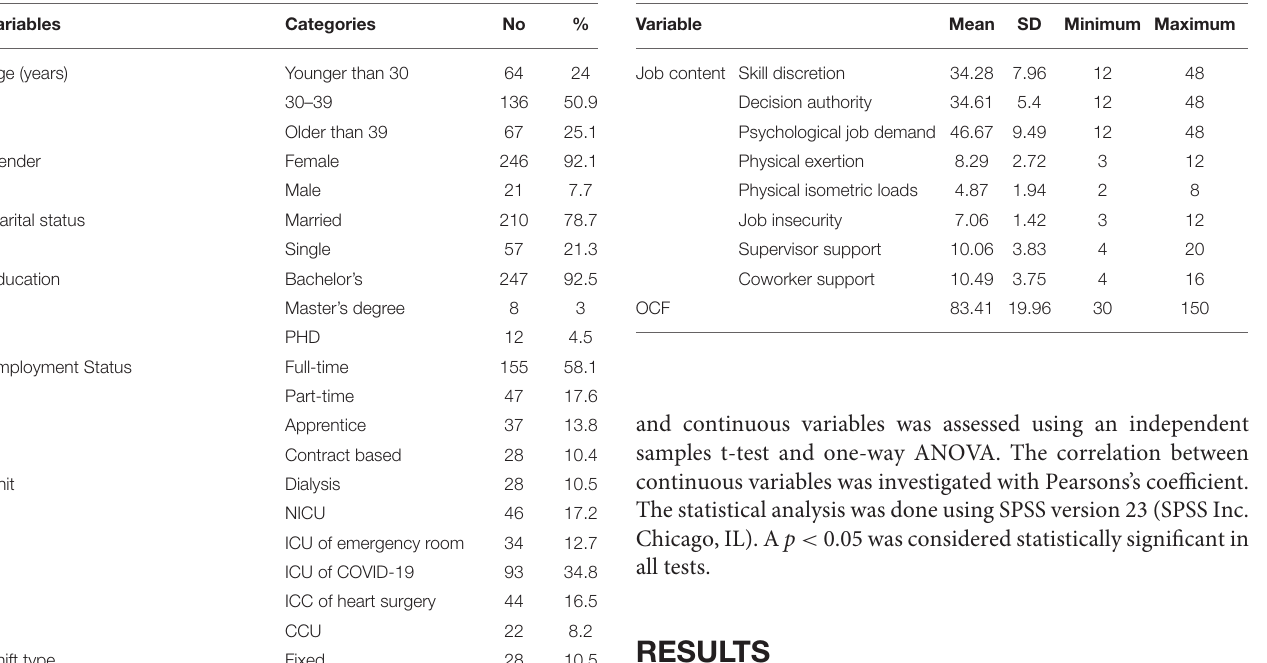
TABLE 2 | Demographic and basic characteristics of the participants. TABLE 3 | Mean and standard deviations of job content and OCF